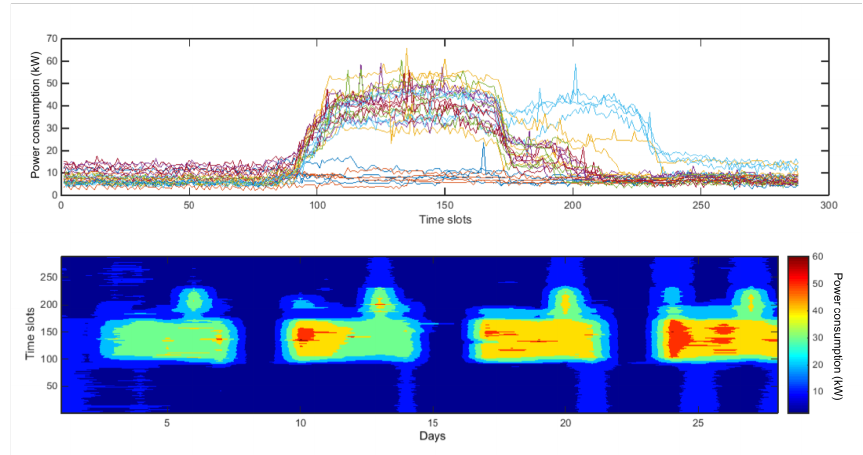
Figure 4. Pilot system: Municipal office (Monopoli). Power consumption